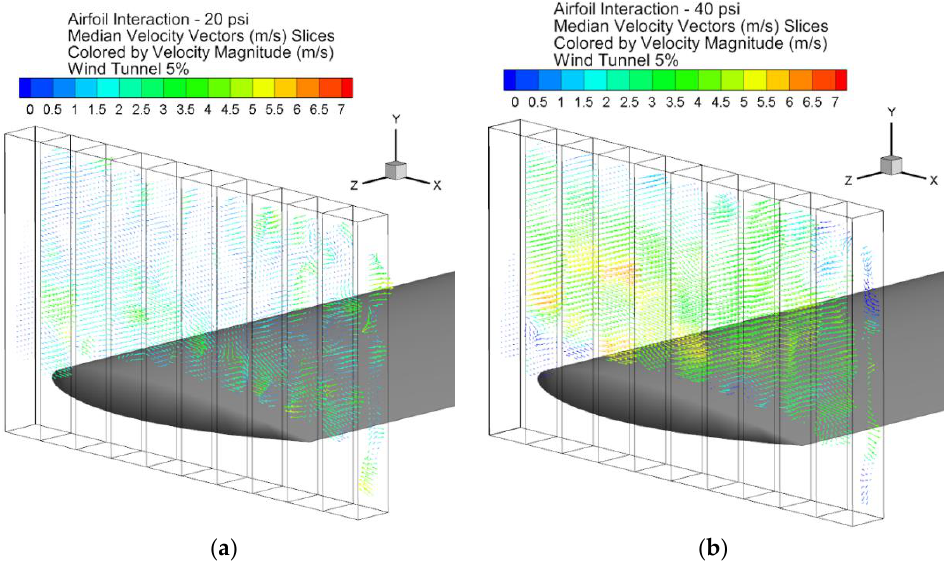
Figure 24. Airfoil interaction instantaneous median frame velocity maps with a 5% freestream setting and the vortex generator set at 20 psi ( a ) and 40 psi ( b ).